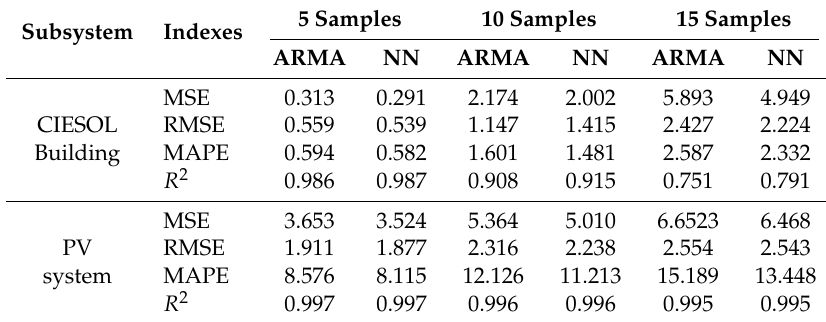
Table 4. Performance indexes for the prediction model of the CIESOL building and the PV system with 5-, 10- and 15-sample prediction